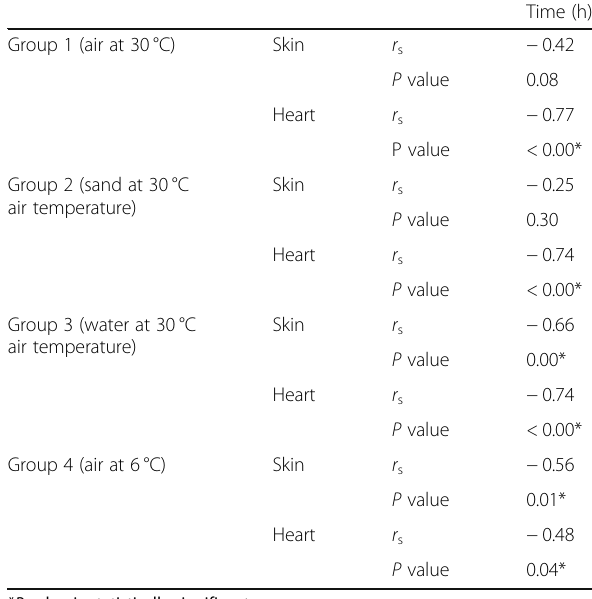
Table 6 Spearman ’ s correlation analysis between the time intervals and the skin and heart GAPDH levels in the different